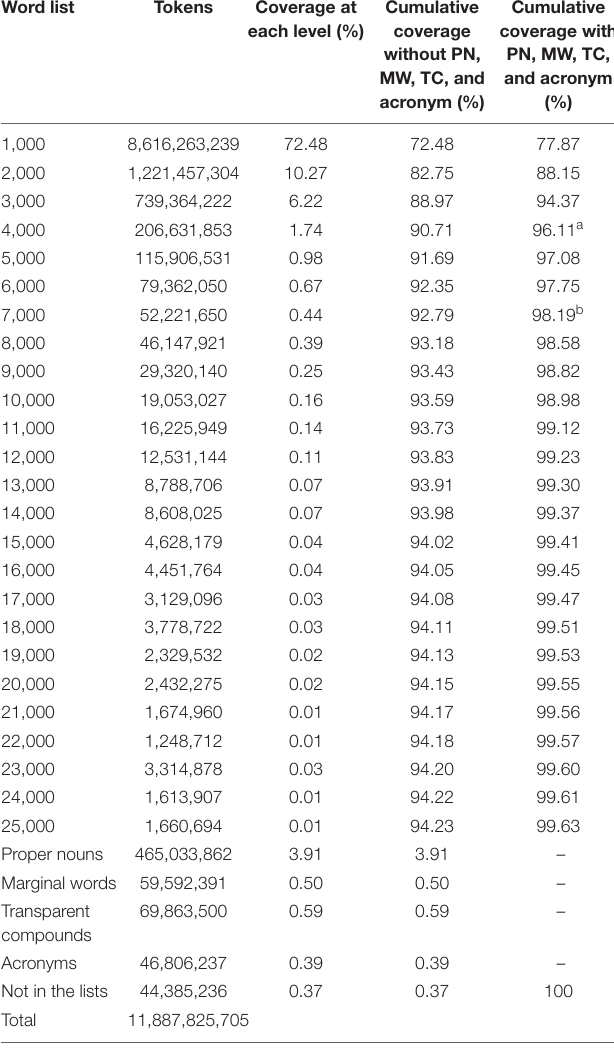
TABLE 1 | The proportions of tokens each word level and the cumulative coverage with and without proper nouns, marginal words, transparent compounds, and acronyms for the News on the Web (NOW)